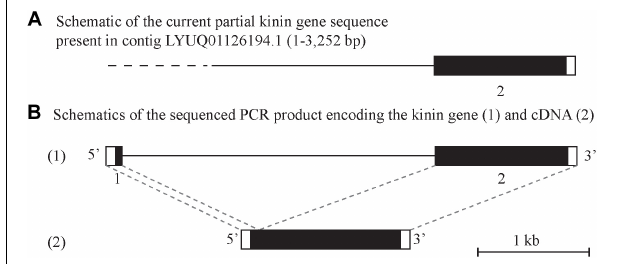
FIGURE 2 | Schematic of the kinin gene and cDNA from Rhipicephalus microplus . The black boxes represent the protein-encoding regions and the white boxes are the untranslated regions on the 5 (cid:48) and 3 (cid:48) -end of the kinin gene or cDNA. (A) Depicts a genome contig fragment (the full length of 7,784 bp is not represented here) encoding the 3 (cid:48) -end fragment of the predicted R. microplus kinin gene (position 1 to 3,252). The dashed line represents the sequence gap at the 5 (cid:48) -end of the kinin gene in the genome assembly (Rm2.0; NCBI). (B) (1) Depicts the amplified 4.1 kb PCR product sequenced that encodes the kinin gene. The gene is composed of two exons (140 and 1,254 bp, respectively, represented by boxes) and one intron (2.7 kb black line). This structure was verified by aligning the gene sequence with the 1398 bp cDNA (2) obtained in this